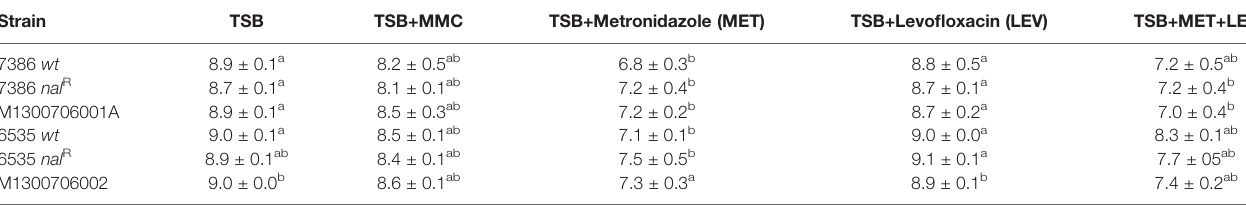
TABLE 2 | Colony counts of the different strains.